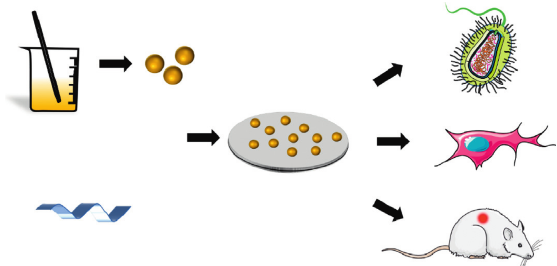
Figure 1: The flow chart of the preparation process and